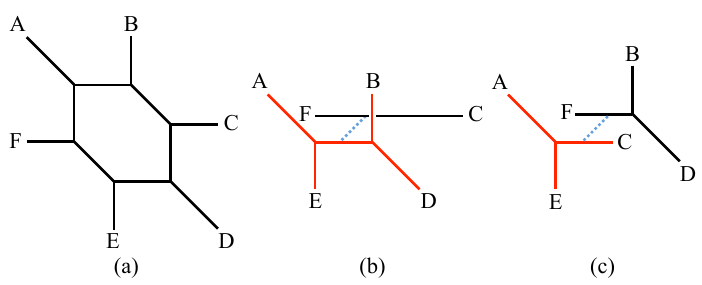
Figure 44. Web diagrams of the two possible complex deformations of dP 3 . The dashed segments indicate S 3